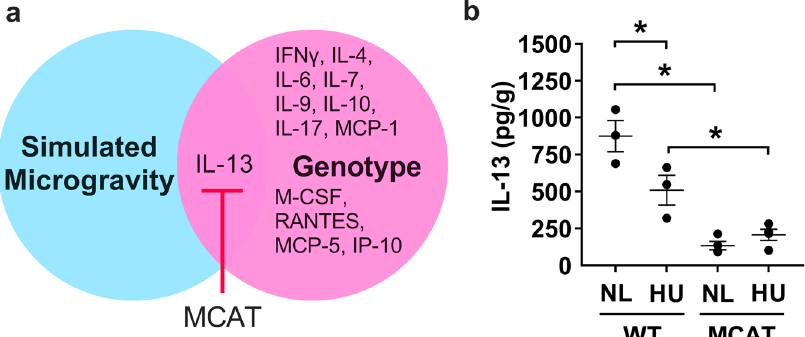
Fig. 3 Effect of combined isolation and simulated microgravity and the impact of MCAT genotype on hippocampal cytokine expression (single housed groups only). a Diagram showing the effects of simulated microgravity and genotype on hippocampal cytokine expression in single housed animals. b IL-13 protein levels showing downregulation by HU and further decreased by MCAT genotype. WT NL ( n = 3), WT HU ( n = 3), MCAT NL ( n = 4), and MCAT HU ( n = 4). Some data points overlap. *Statistically signi fi cant at p < 0.05 by two-way ANOVA and Tukey post hoc test.